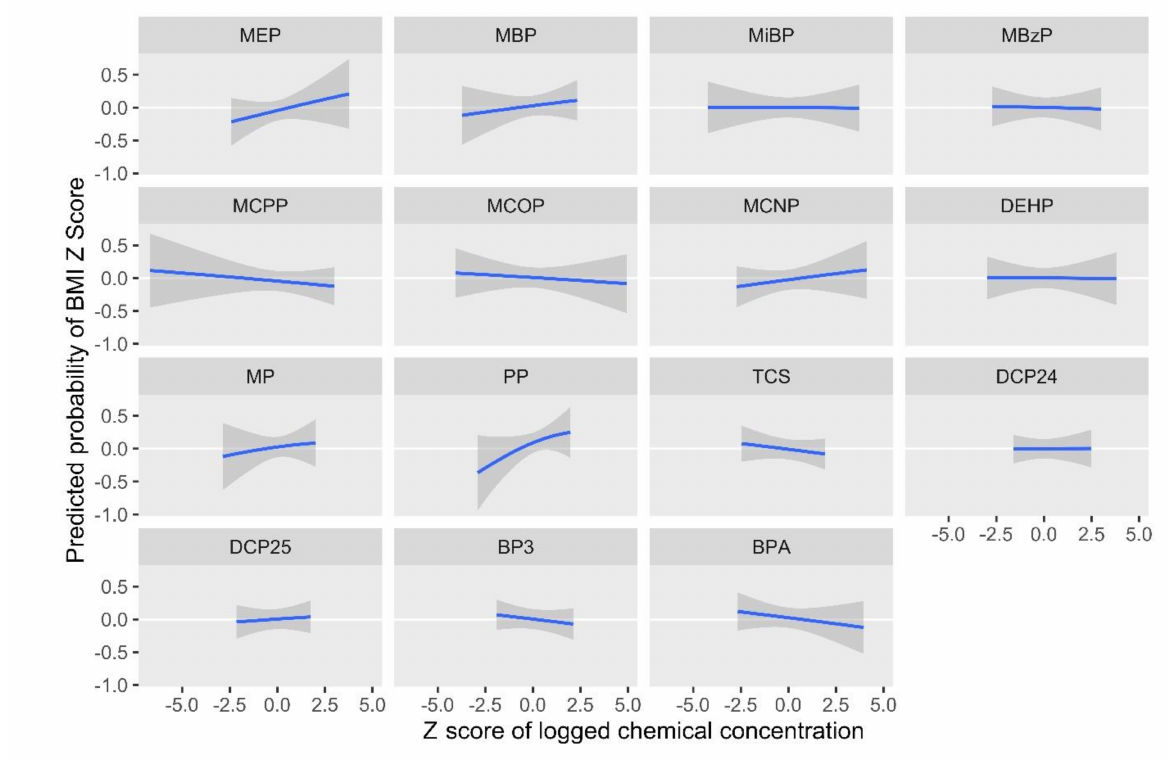
Figure 2. Predicted probability of the body mass index z -score by log2 biomarker concentration z -scores, holding all other biomarkers at their